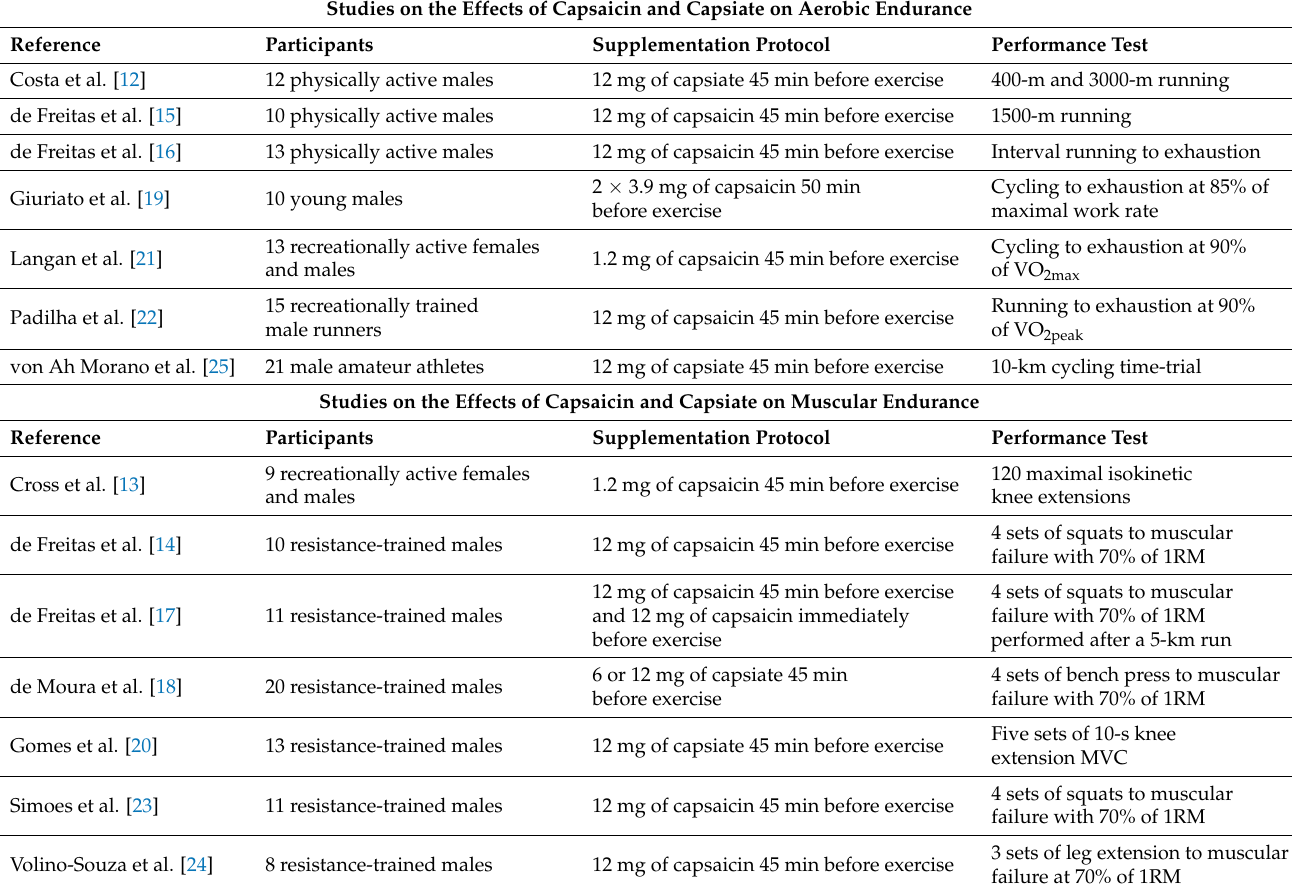
Table 1. Summary of the included